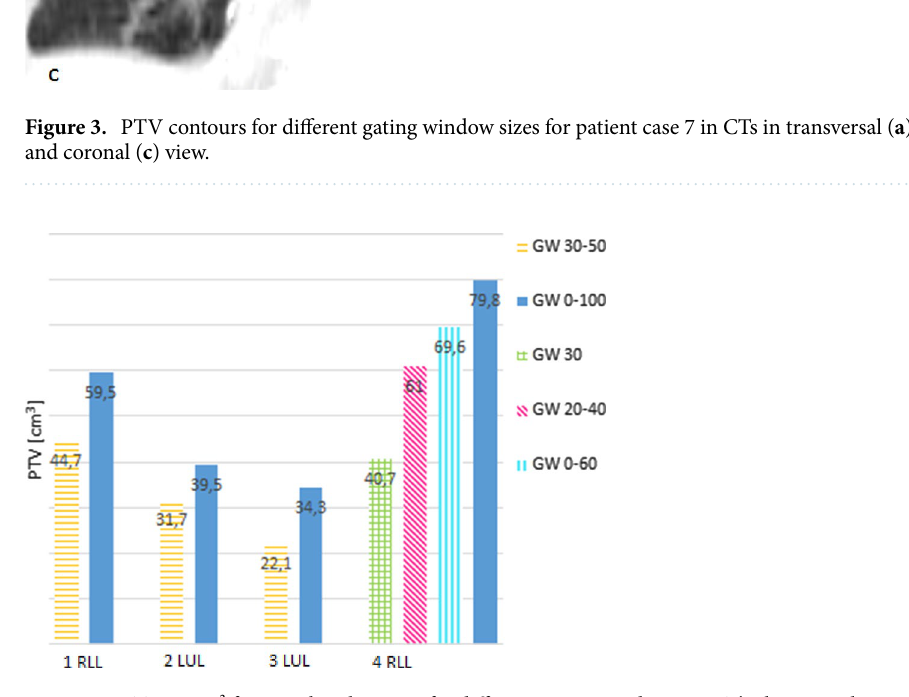
Figure 4. PTV in cm 3 for peripheral tumors for different gating window sizes. The horizontal axis caption refers to the patient case and the